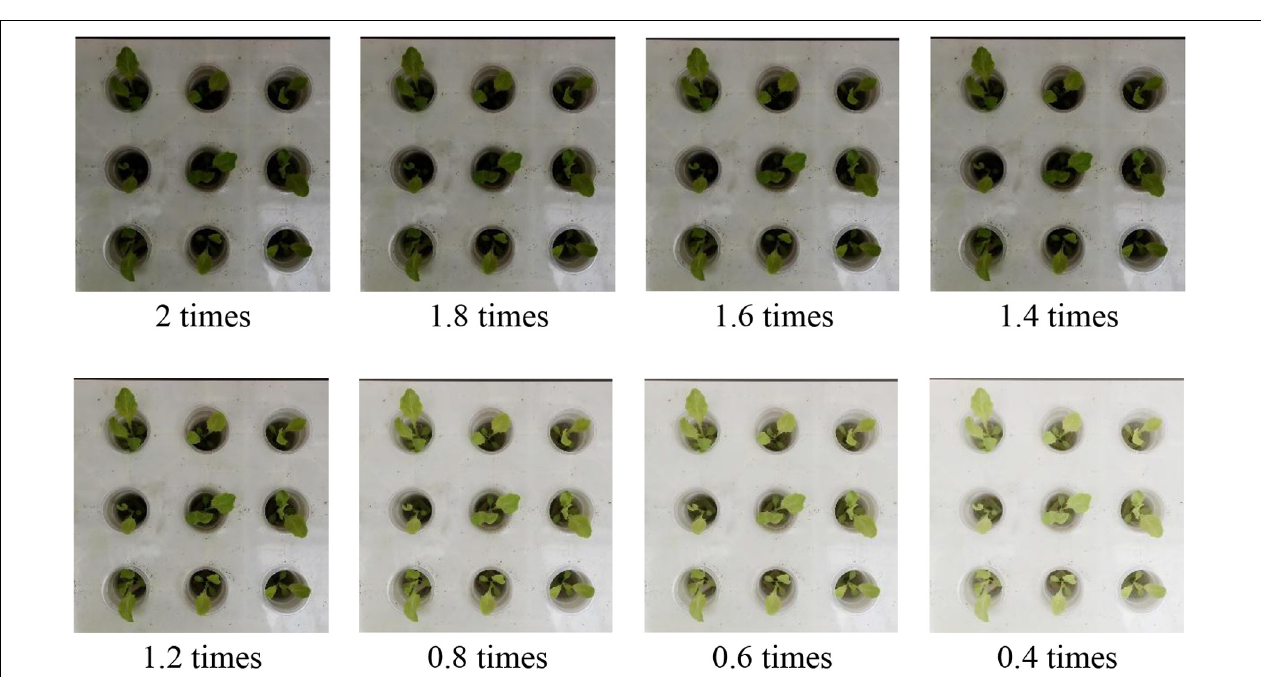
FIGURE 3 | The whole process from seedling to transplanting of the lettuce. The whole process mainly included 3 stages, namely seedling, separating from seedling cotton, and transplanting.